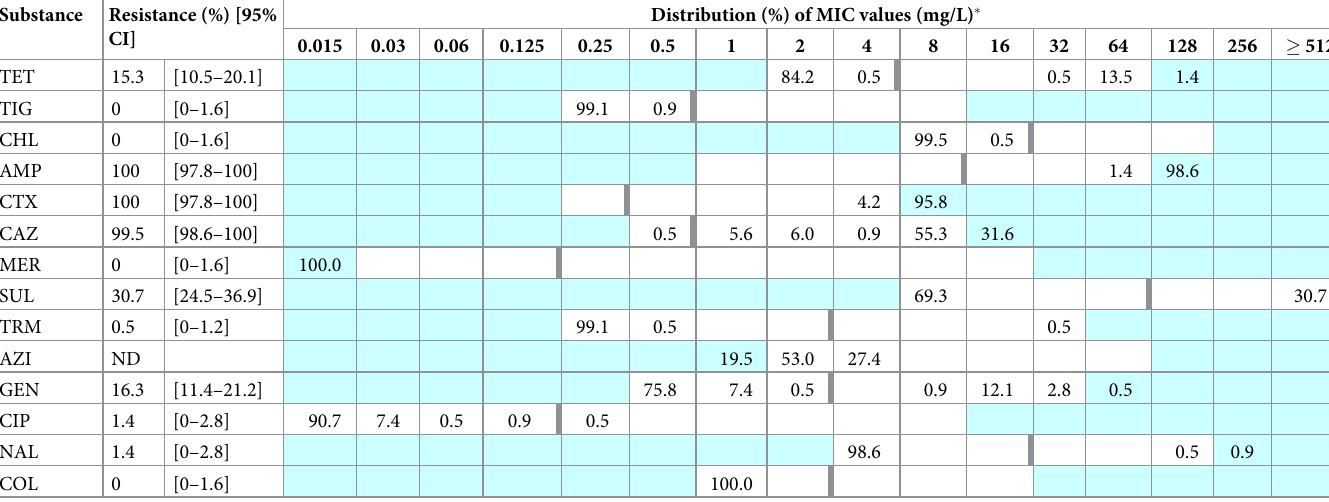
Table 1. Antimicrobial susceptibility testing. Minimum inhibitory concentrations (MICs) and antimicrobial resistance of extended-spectrum beta-lactamase-resistant Escherichia coli isolates (n = 215) with plasmid-mediated resistance mechanisms originating from Norwegian broiler flocks sampled during May-October 2016.